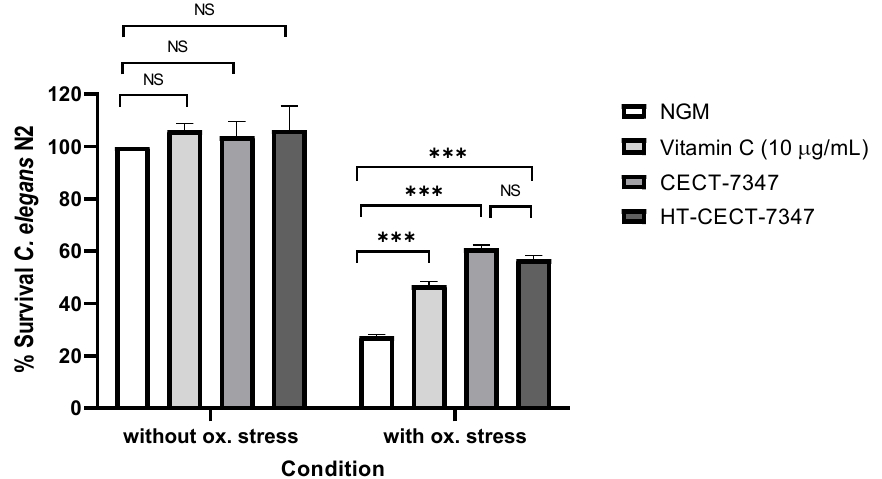
Figure 1. Survival of C. elegans (N2) fed with B. longum CECT-7347 or HT-CECT-7347 without oxidative stress and after acute oxidative stress. NGM: Nematode growth medium used as control feeding condition. *** Significant p < 0.001; NS: No significant differences. One-way ANOVA was applied. Data are the average of two independent experiments ( n =